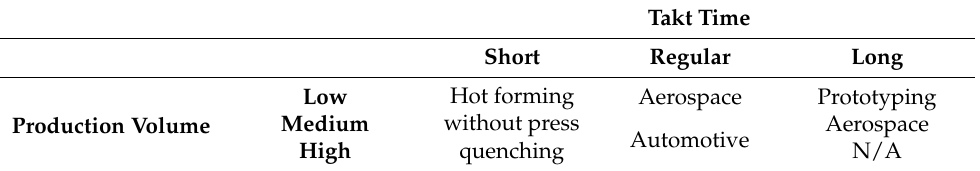
Table 2. Summary of the preliminary comparison of the three studied tool material